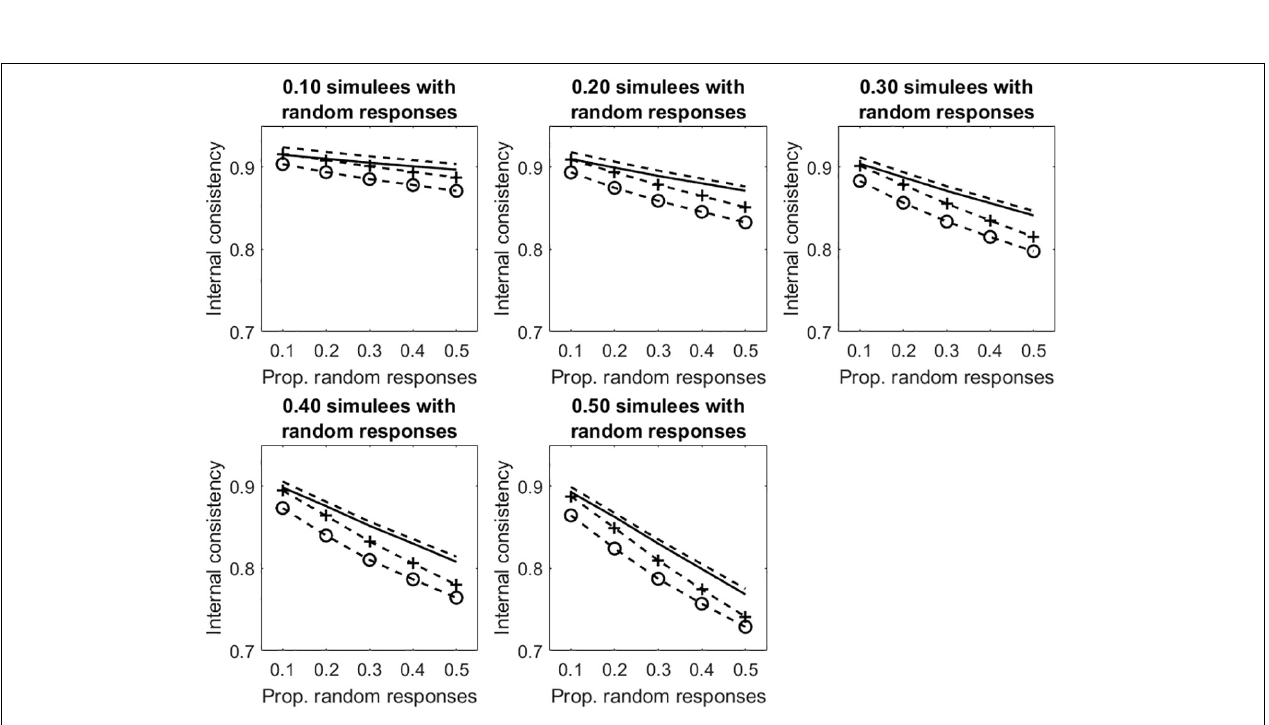
FIGURE 5 | Average internal consistency for the different proportions of simulees with random responses and the different proportions of polytomous items with random responses. The solid line represents α , the unmarked dashed line represents R, the +-marked dashed line represents infit-corrected R, and the o-marked dashed line represents the outfit-corrected